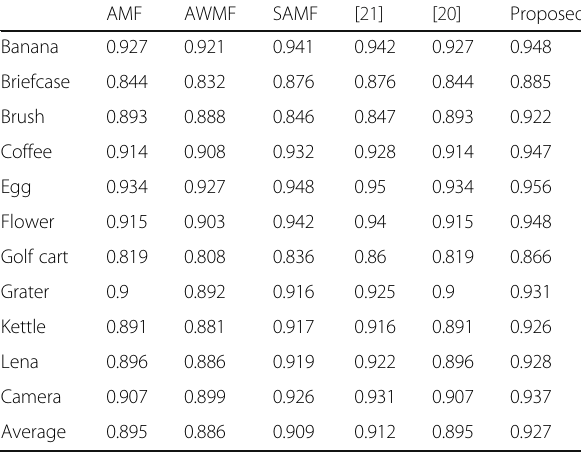
Table 8 MSSIM comparison for 50% noise